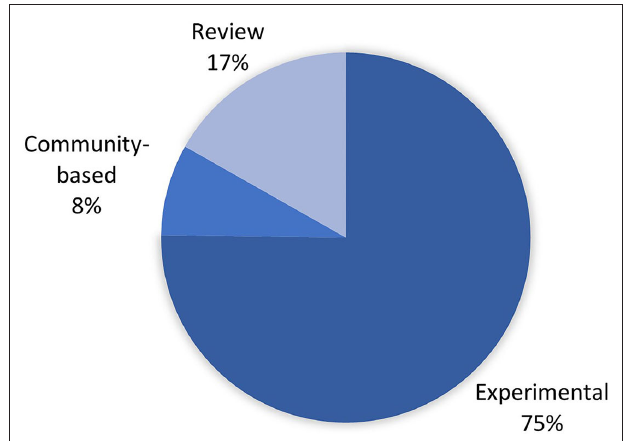
FIGURE 1 | Publications addressing fog water collection, based on three categories—experimental, review, and community-based (operational)—expressed in terms of the percentage of total articles.